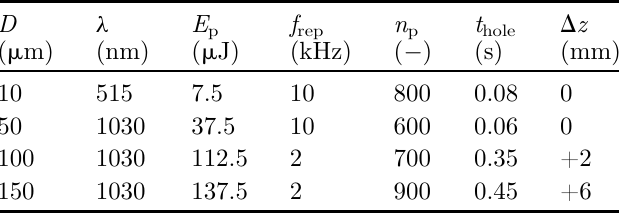
Table 1. Applied laser parameters for the texturing of the different mask con fi gurations.